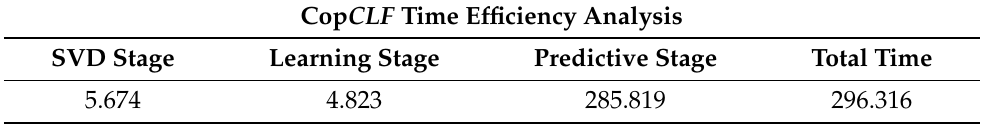
Table 4. Average computation time spent, in seconds, with Cop CLF for each stage of the algorithm. The total average time (column 4) is the sum of the time spent for all stages by launching the algorithm 10